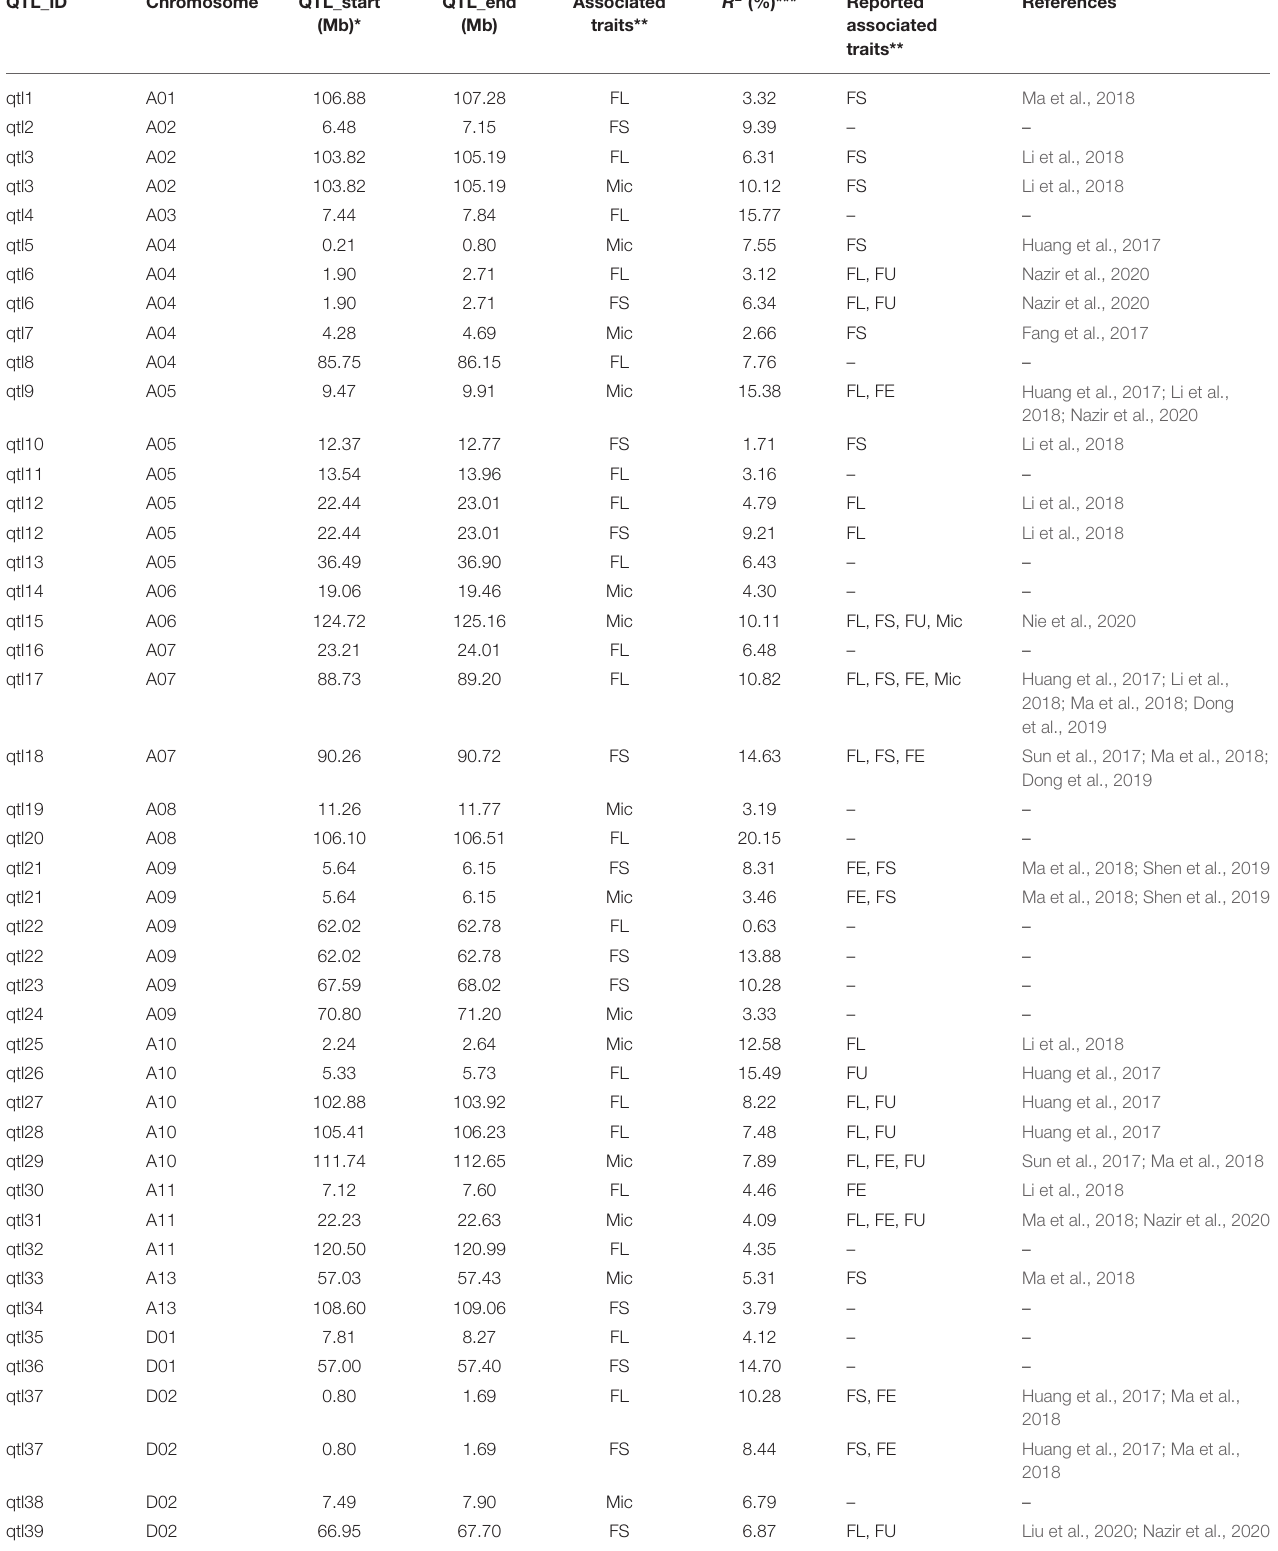
TABLE 2 | Stable QTLs and co-located QTLs identified for fiber length, fiber strength, and fiber micronaire.